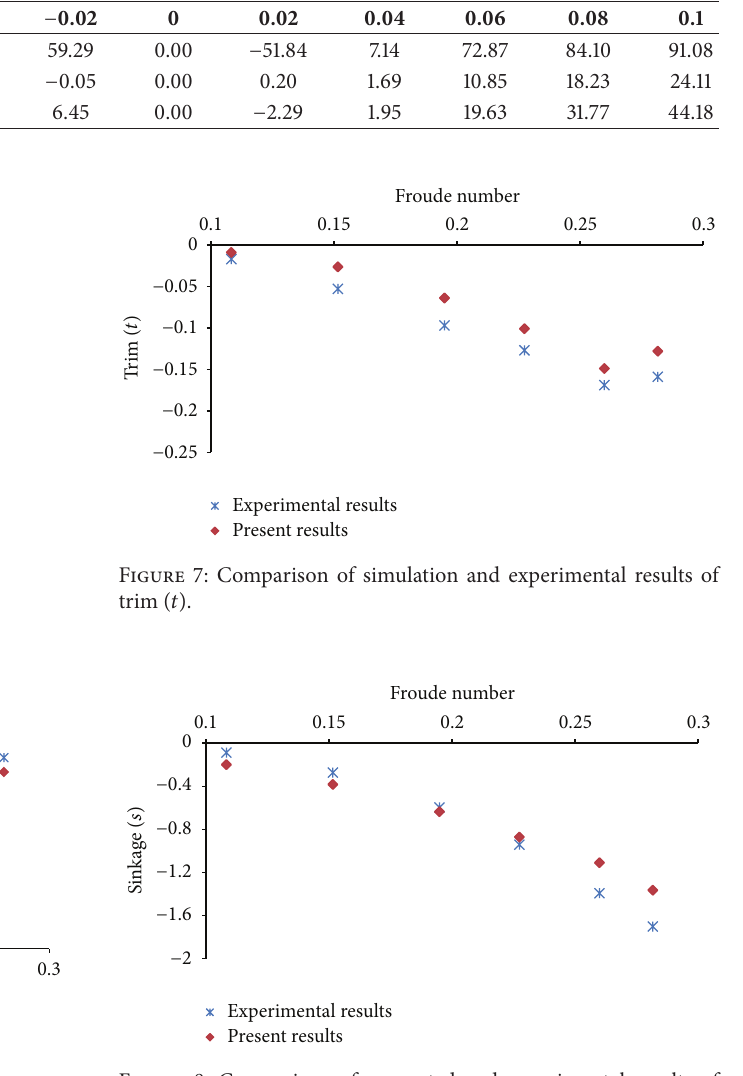
Figure 8: Comparison of computed and experimental results of sinkage ( 𝑠